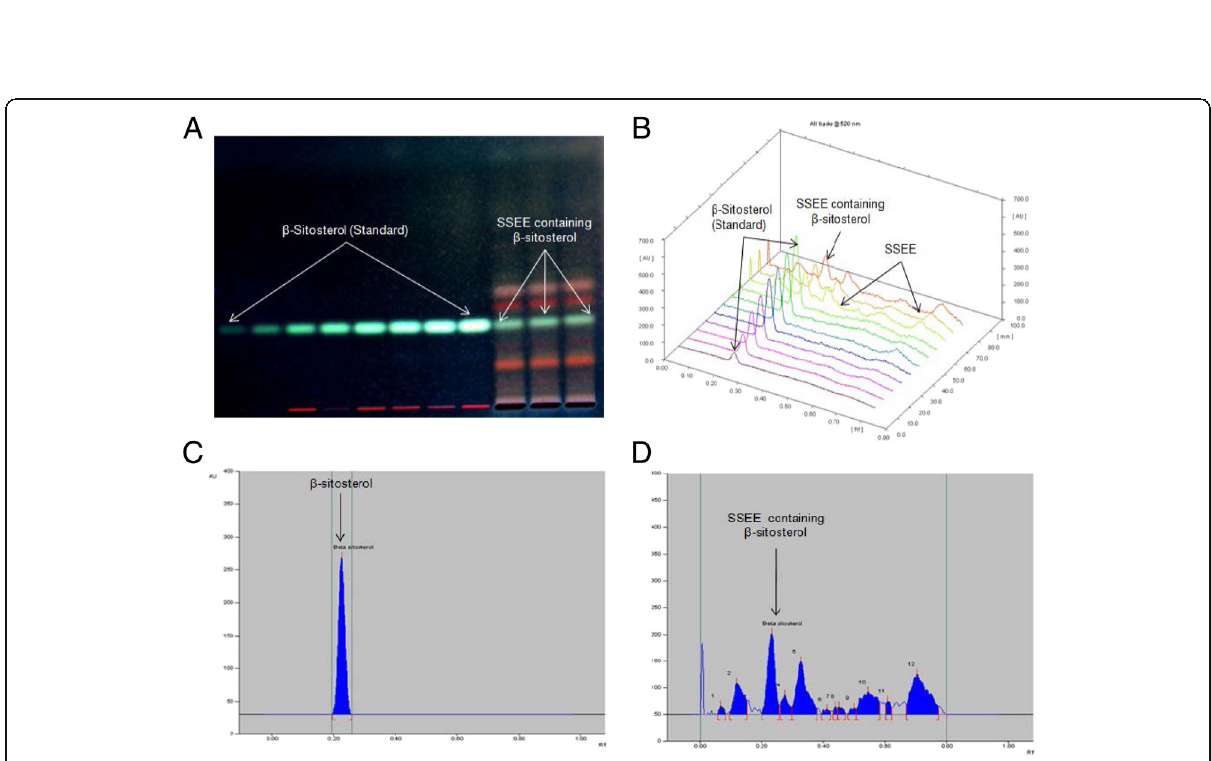
Fig. 4 HPTLC standardization of β -sitosterol in the S. surattense ethanol-extract (SSEE, λ = 360 nm, mobile phase- hexane:ethyl acetate, 4:6, v/v). a chromatogram showing β -sitosterol biomarker (600 ng spot − 1 , peak 1, R f = 0.23); ( b ) chromatogram of SSEE containing β -sitosterol (peak 3, R f = 0.23); ( c ) pictogram of developed and derivatized HPTLC plate of SSEE; ( d ) 3-D display of all tracks